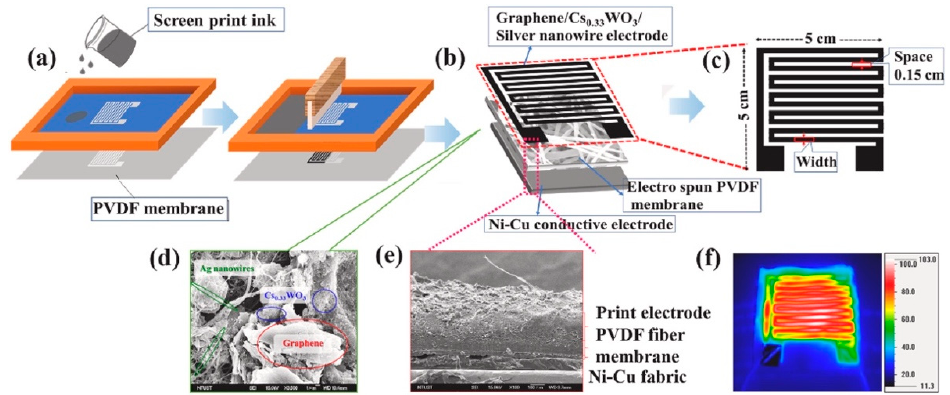
Figure 16. The main components and materials of the PyNG were reported by Gokana et al. [91]. ( a ) Schematic diagram of the elaboration of the serpentine electrode (SRE) using screen ‐ printing. ( b ) Schematic diagram of structural design and materials of the SRE PyNG. ( c ) Dimensions of the SRE pattern. FESEM images of ( d ) surface and ( e ) cross ‐ sectional view of the PyNG. ( f ) Temperature response of the PyNG using IR thermographic. Reprinted with permission from [91]. Copyright 2022, Elsevier B.V.